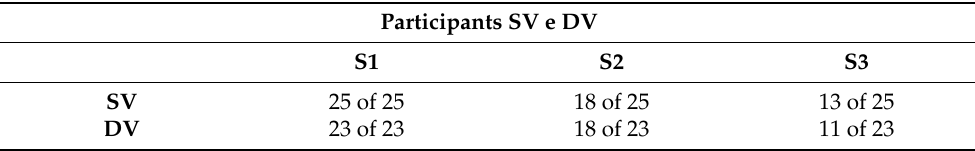
Table 6. Number of participants per scenario SV and